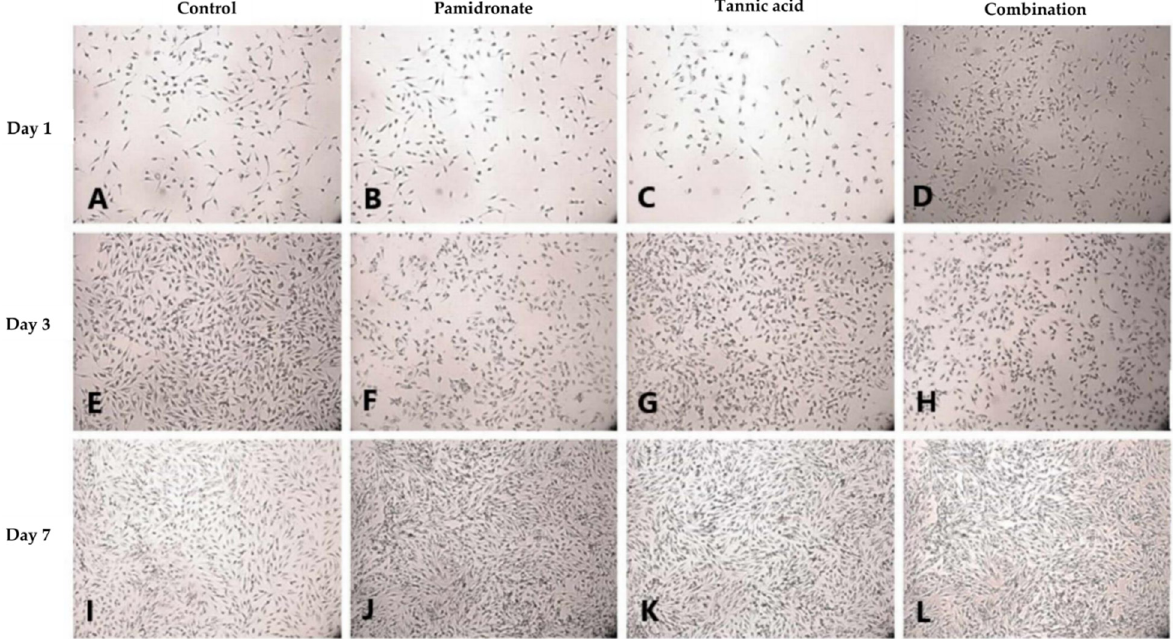
Figure 4. In cell culture, von Kossa staining using silver nitrate is widely used to detect mineralization ( A – L ). von Kossa staining for phosphate (P) deposits in hFOB 1.19 cells for 1, 3, and 7 days in the control group (DMSO treated), tannic acid (TA)-treated group, pamidronate (PAM)-treated group, and the combination of TA and PAM (75:25) observed using an image analyzer (magnification: 22 × ). The reaction between silver nitrate in von Kossa and P formed black spots, which represents phosphate